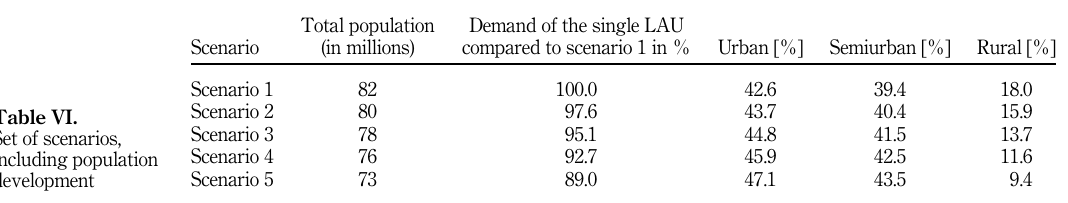
Table VI. Set of scenarios, including population